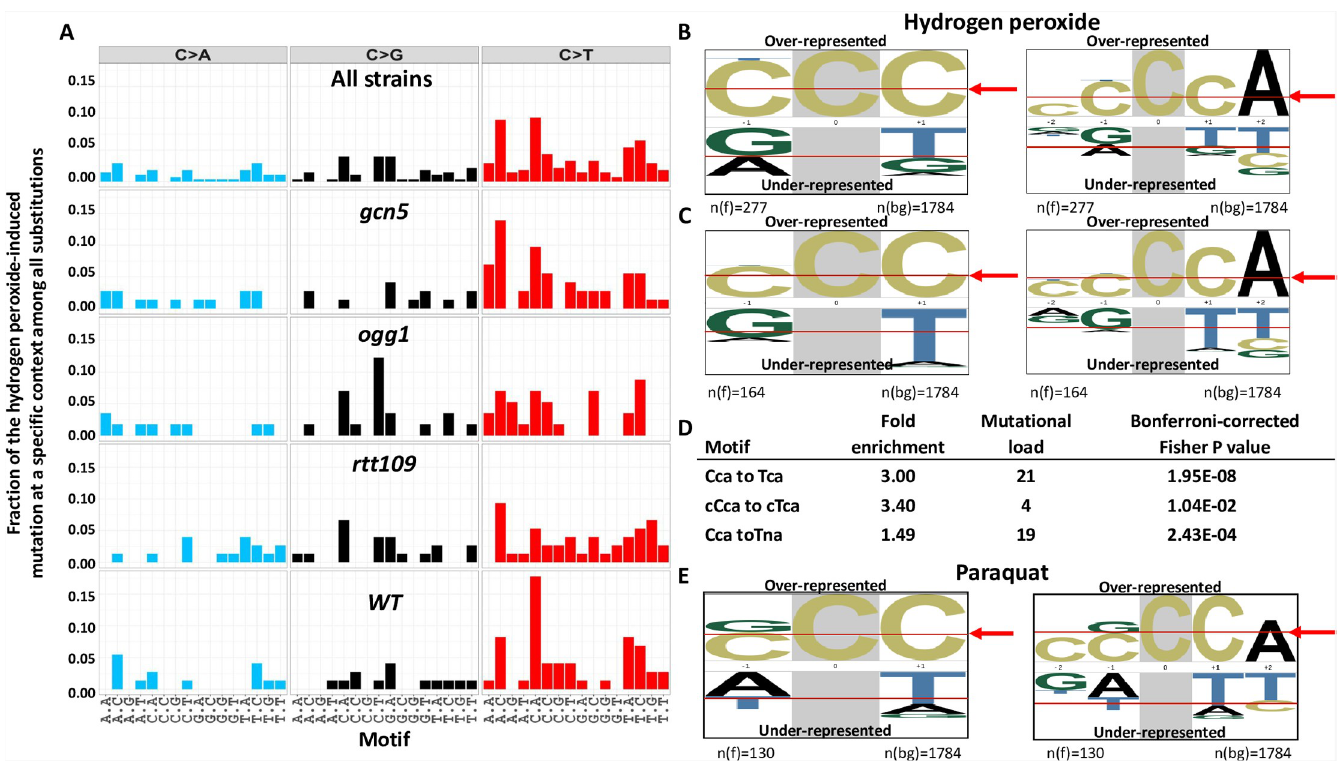
Fig 7. Signature of redox stress–induced DNA damage in ssDNA. A. Fractions of the mutations at C in specific trinucleotide motifs among all of the substitutions detected. B. Overrepresented nucleotides in tri- (left) or pentanucleotide (right) motifs flanking hydrogen peroxide–induced substitutions at C identified by pLogo analysis [40]. The height of each letter indicates the magnitude of over- or underrepresentation. The foreground n (fg) = 277 is the number of all substitutions at C. The background n (bg) = 1784 is the number of C in the sequence of the subtelomeric triple reporter. The enrichment for the nucleotides above the red arrows is statistically significant, P < 0.05. C. Enrichment for the motifs flanking C to T substitutions in hydrogen peroxide–induced mutations (pLogo analysis). The foreground n (fg) = 164 are all C to T mutations identified in mutants. D. Fold enrichment for specific motifs (Materials and methods and [13]). The capital C and T indicates the site of C to T mutation; n stands for any nucleotide. E. Enrichment for the motifs flanking C substitutions in paraquat-induced mutations in sod1 strains (pLogo analysis). The foreground n (fg) = 130 are all mutations at C identified in mutants. ssDNA, single-strand